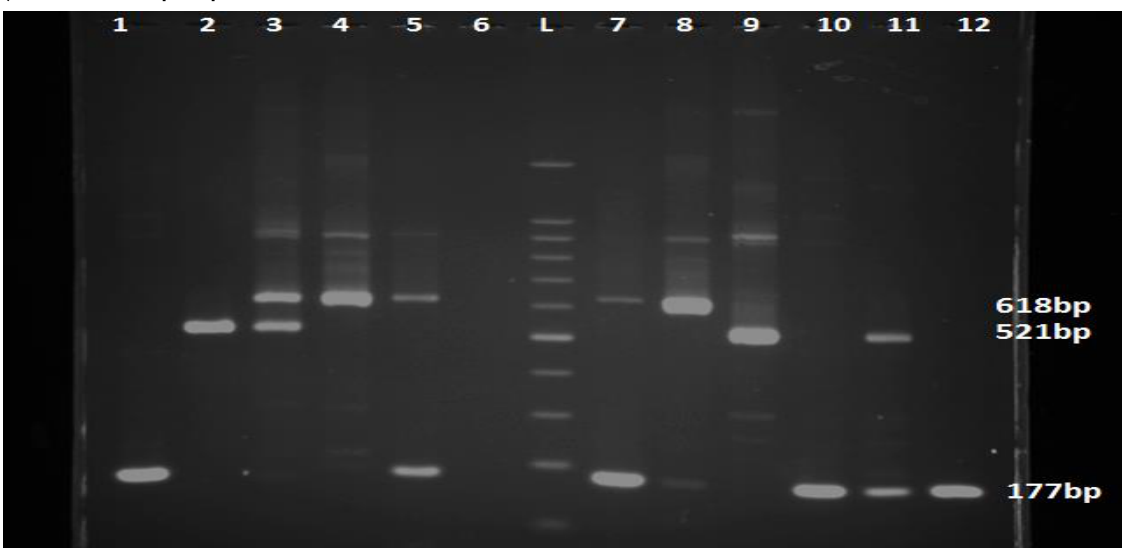
Figure 2. Agarose gel electrophoresis of first round PCR. ( Lanes 1-9 : 881 bp of VP7 amplified fragment , lane L : 100 bp step DNA ladder).